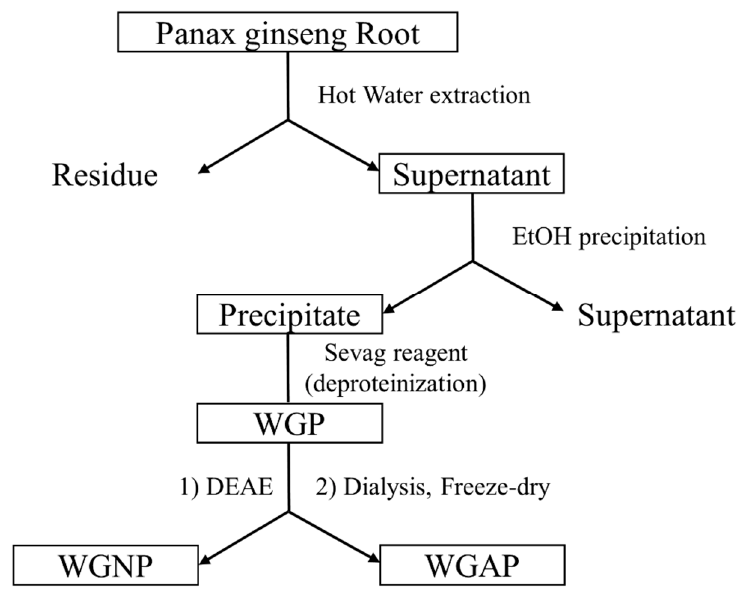
Figure 1. The flowchart of extraction of ginseng polysaccharide fractions.